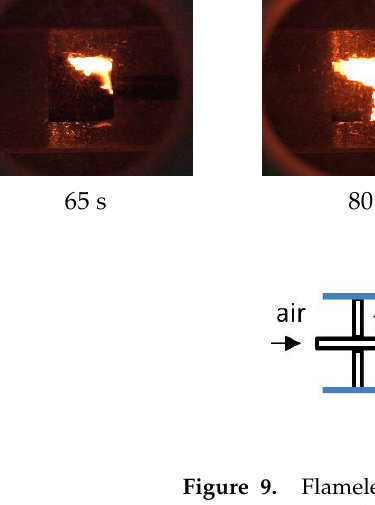
Figure 9. Flameless combustion of the sample in an inert channel, T furnace—600 °C, air velocity—40 m s − 1 , type B holder with a steel cover ( a ). The following images show the time starting from the moment the sample is put into the furnace. Diagram ( b ) explains the location of the particle and the elements of the rig.